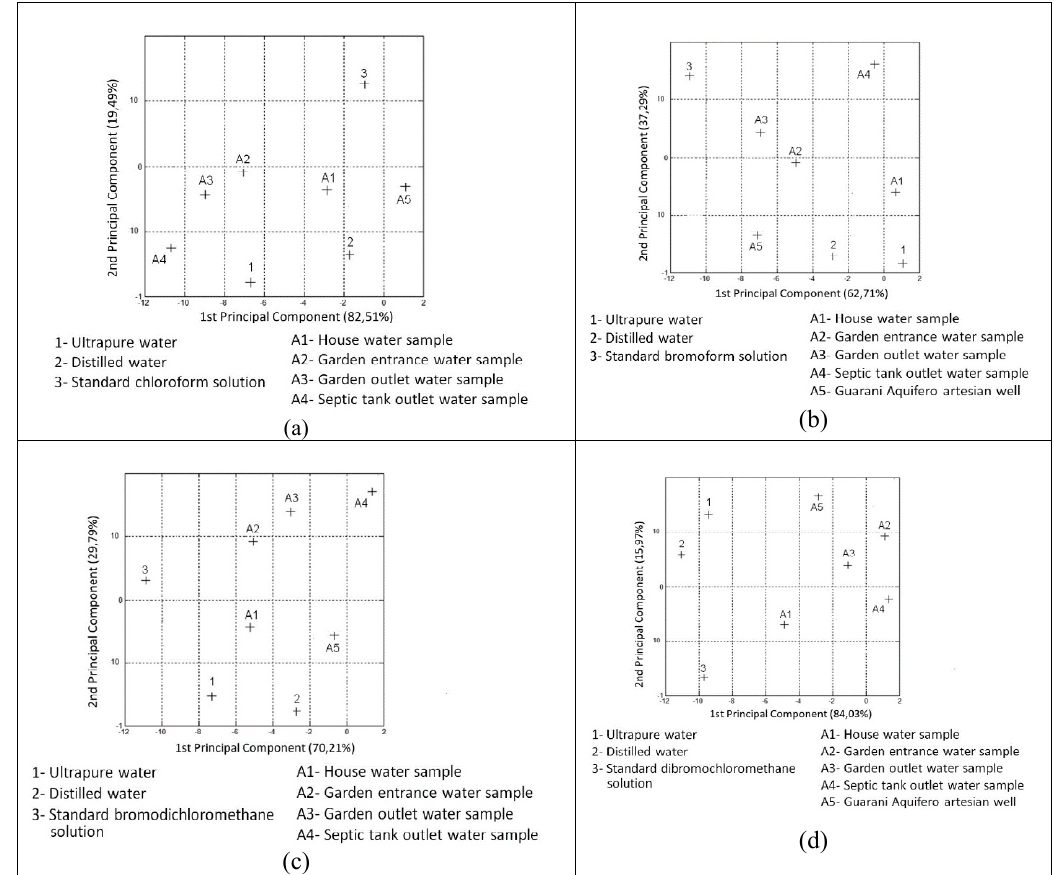
Fig. 9. Principal Component Analysis (PCA) for septic tank effluent samples, ultrapure and distilled water, contaminated with TTHM (s). In (a) samples contaminated with chloroform; in (b) samples contaminated with bromoform; in (c) samples contaminated with bromodichloromethane and, in (d) samples contaminated with